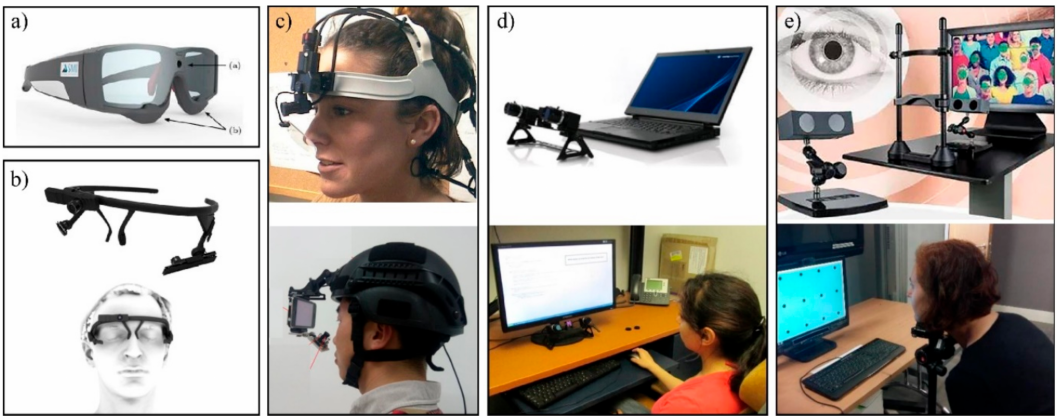
Figure 7. Example of the different types of eye tracking devices: ( a ) eye tracking glasses [75]; ( b ) headband [92]; ( c ) helmet- mounted [130,131]; ( d ); remote or table [132]; ( e ) tower-mounted